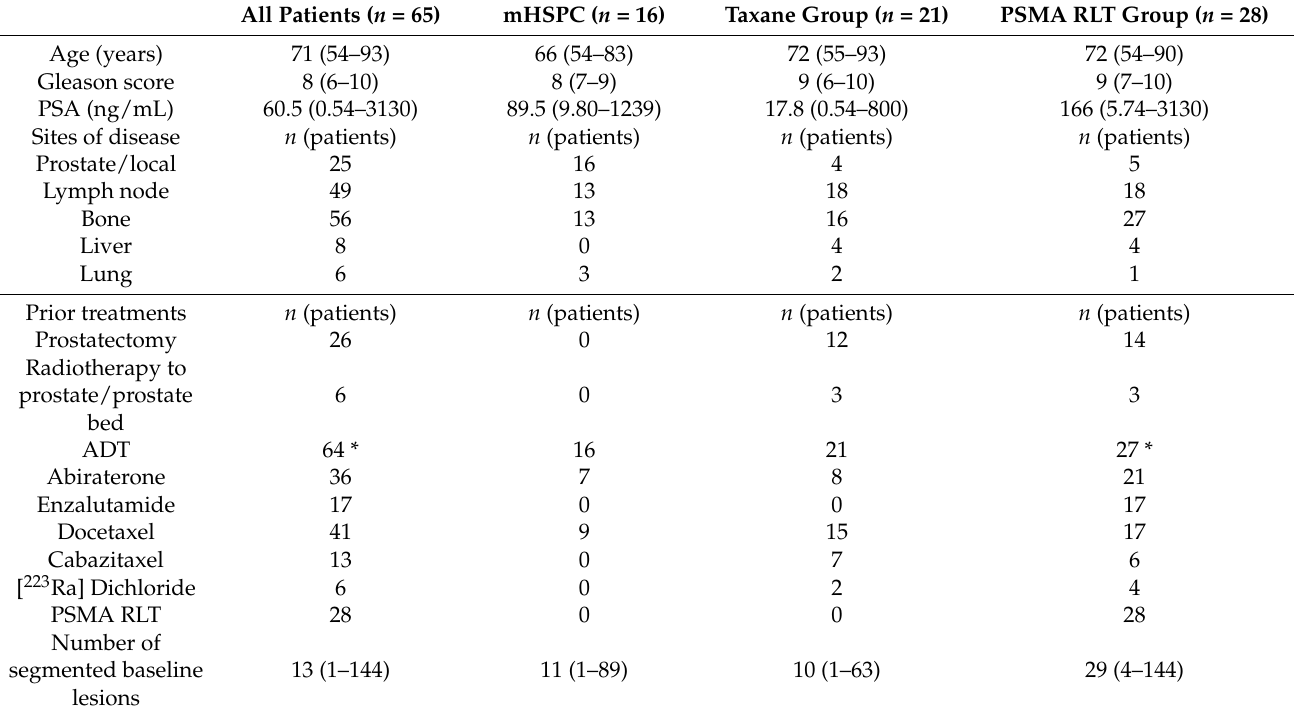
Table 1. Patient